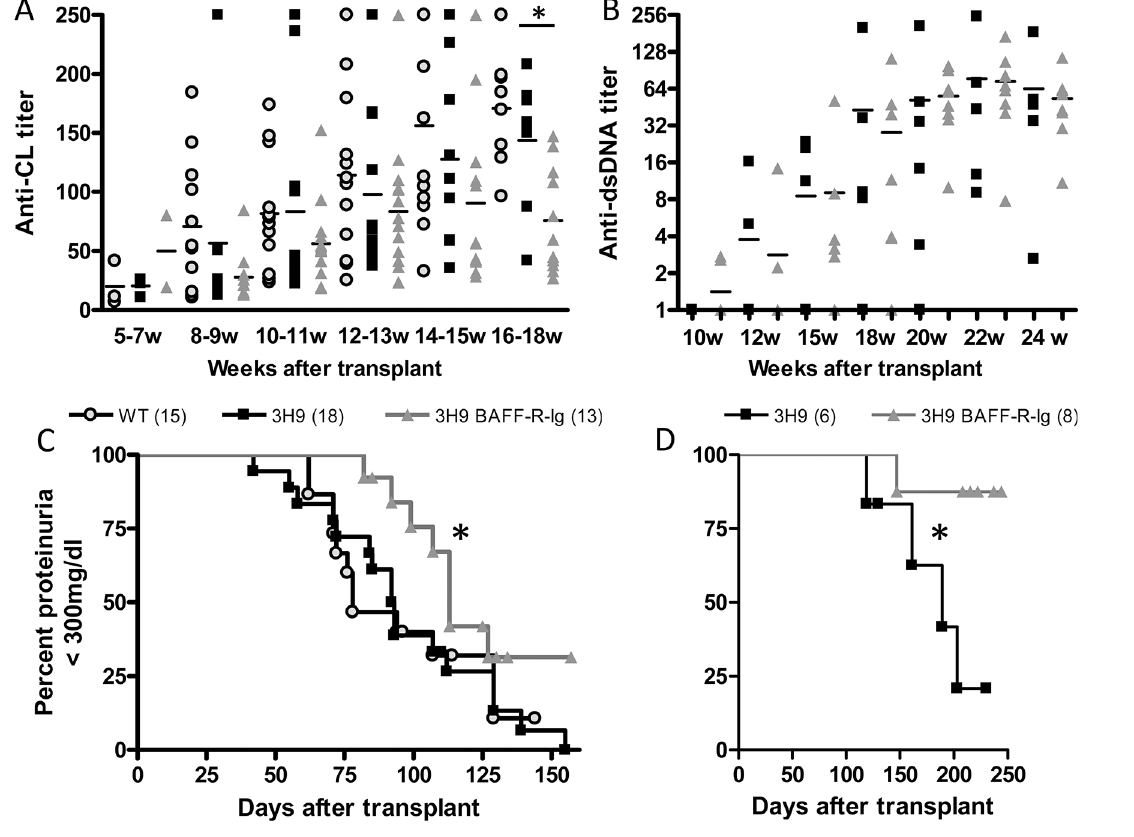
Figure 1. Clinical outcomes of BAFF-R-Ig–treated 3H9 chimeric mice. (A, C) Male NZW/BXSB mice. (B, D) Female NZB/W mice. (A, B) ELISA values for each antigen were normalized to a high titer control run on each plate and are shown for each individual mouse at the indicated times after bone marrow transplant. The horizontal bar indicates the mean for each grou p (* p < 0.05). (C, D) Kaplan-Meier plots show signifi- cant delay in the onset of fixed 300 mg/dL proteinuria in BAFF-R-Ig–treated mice of both strains (* p < 0.05 versus untreated